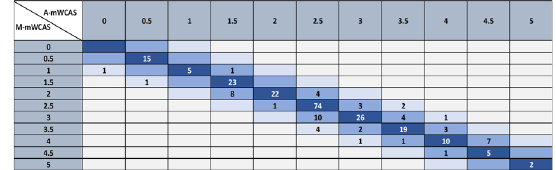
Fig. 1 The agreement matrix showing the agreement between the